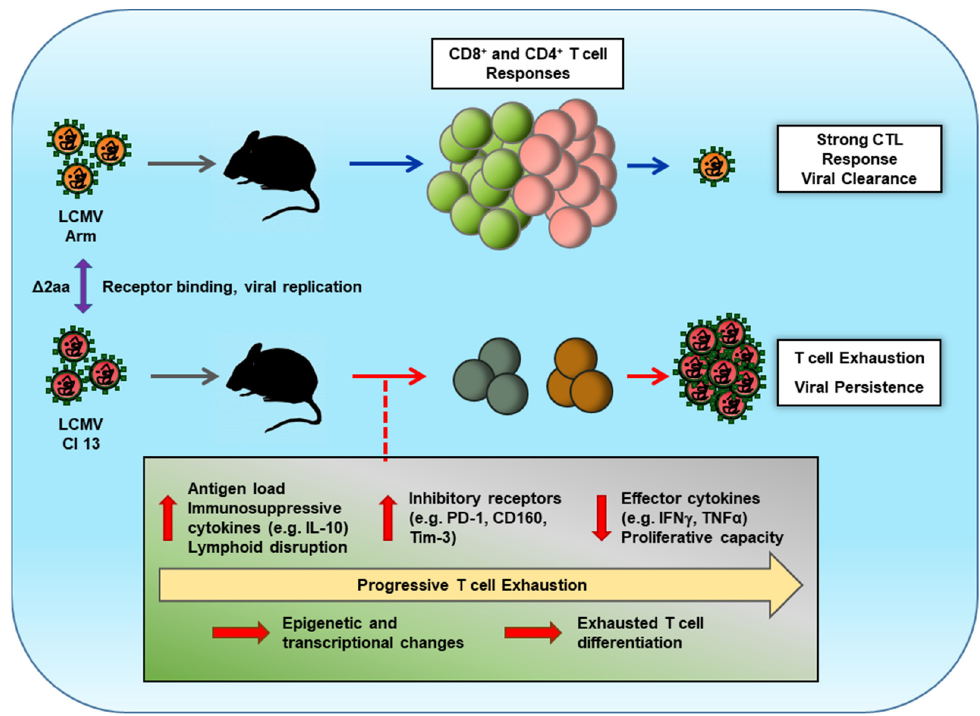
Figure 1. Infection of mice with differing LCMV strains leads to variable T cell responses impacting viral clearance. The prototype strain of LCMV, Armstrong 53b (Arm), readily infects mice. How- ever, a strong host CD8 + T cell response and an ancillary CD4 + T cell response are able to clear the viral infection quickly. However, a variant strain of LCMV, Clone 13 (Cl 13), has two functional amino acid (aa) changes, which affect the virus’s ability to bind to its receptor and replicate in